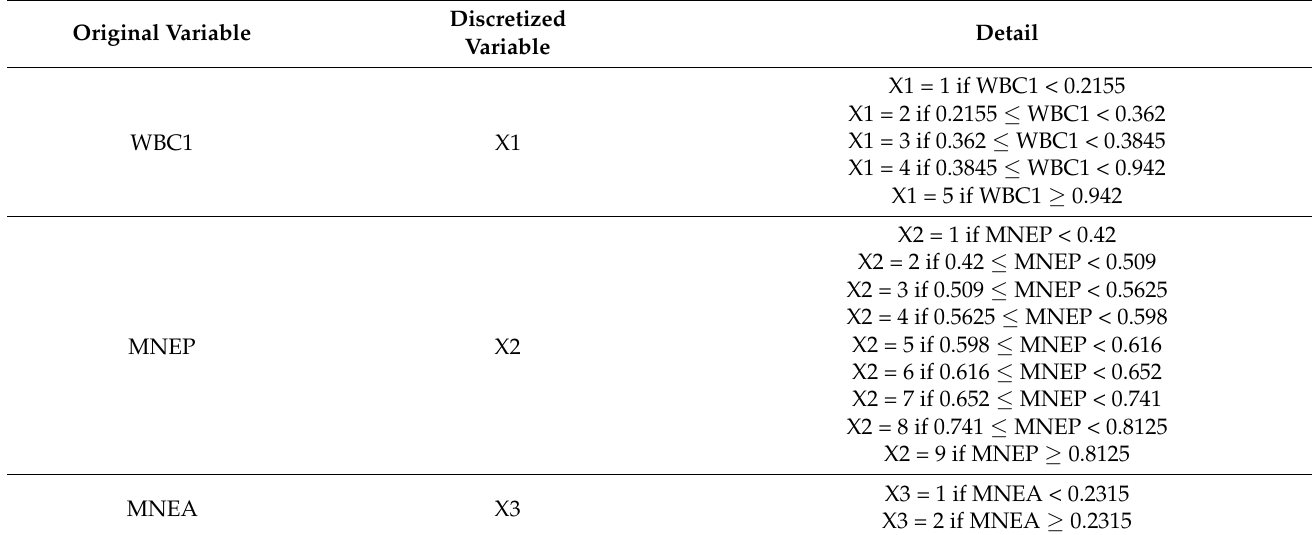
Table 8. Discretized variables generated by the classification tree: appendicitis